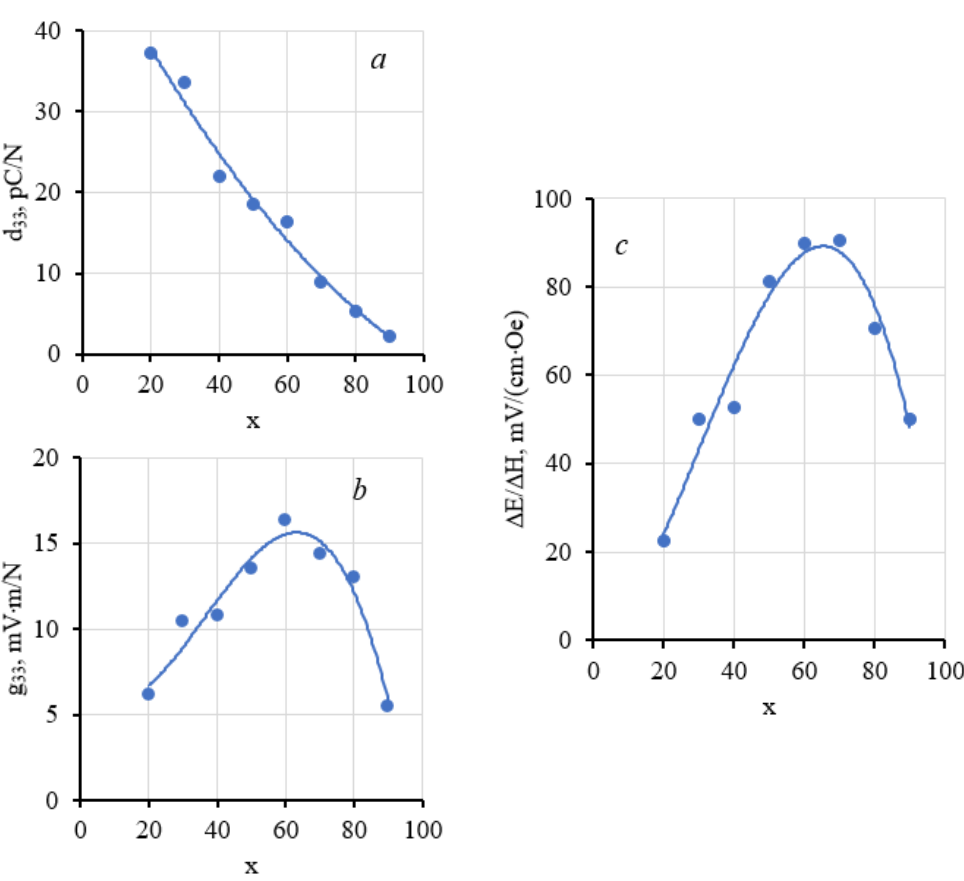
Figure 7. Concentration dependences of the piezoelectric coefficient ( a ), piezoelectric voltage con- stant ( b ), and ME coupling coefficient ( c ) of (100 − x) wt.% BCZT + x wt.% NCCMF composites.